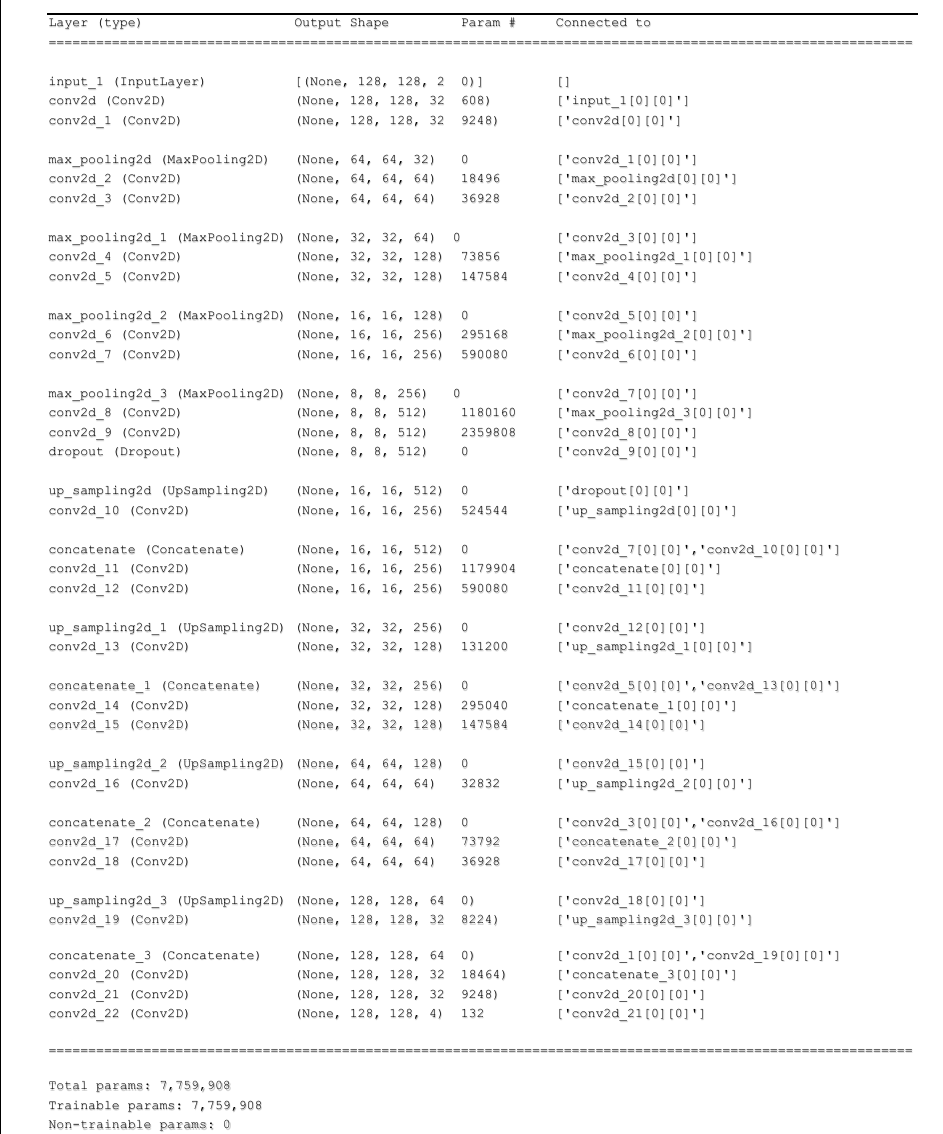
Figure 5. U-Net model